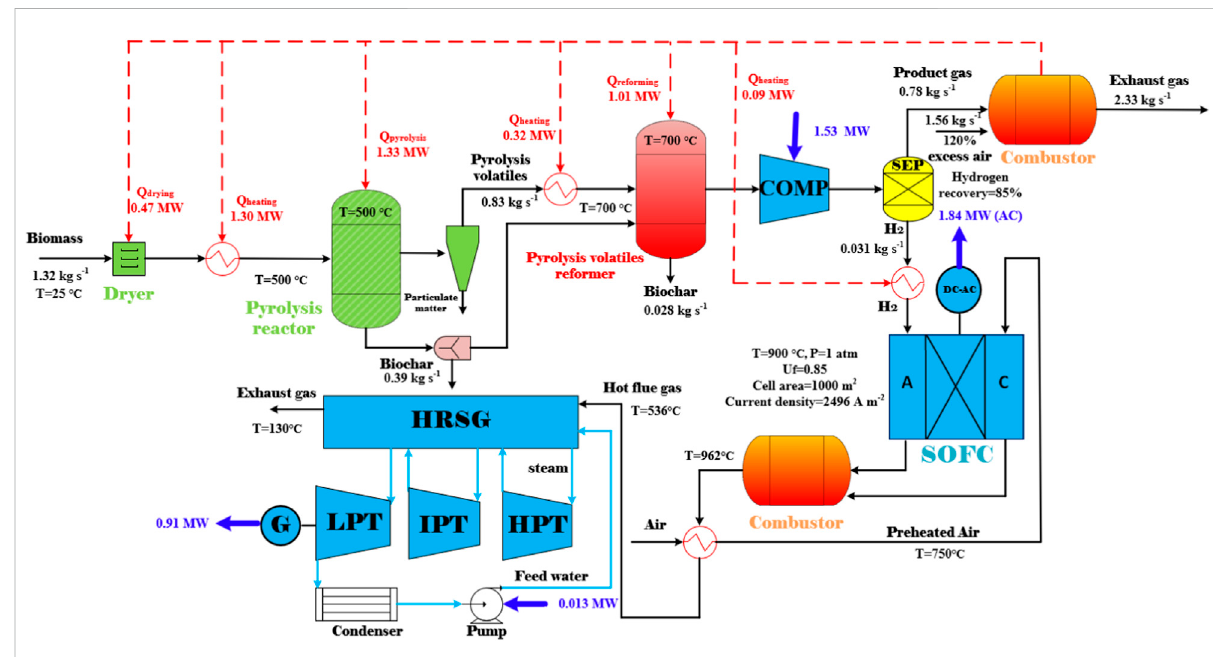
FIGURE 9 The stand-alone design of the BP-SOFC-CHP system for the co-generation of biochar and